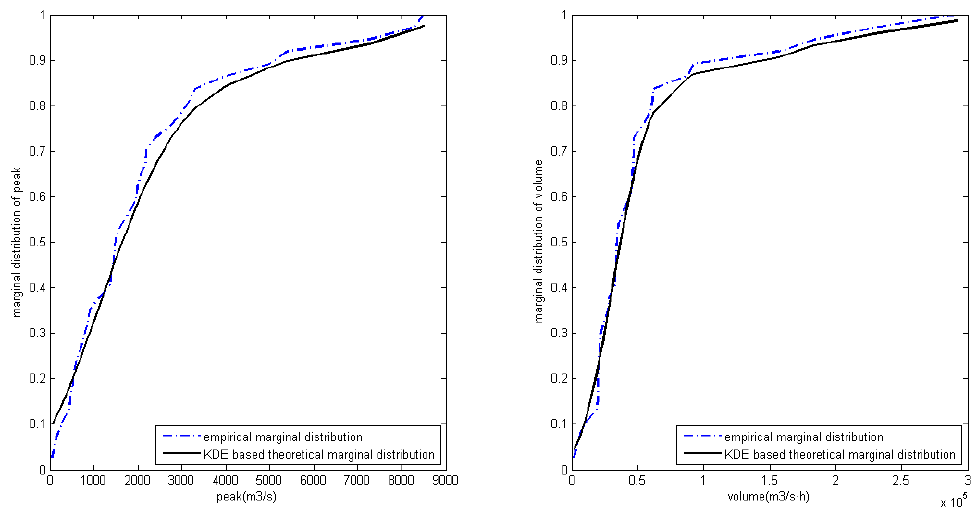
Figure 6. Empirical and kernel density estimation (KDE)-based theoretical distribution for peak and volume.